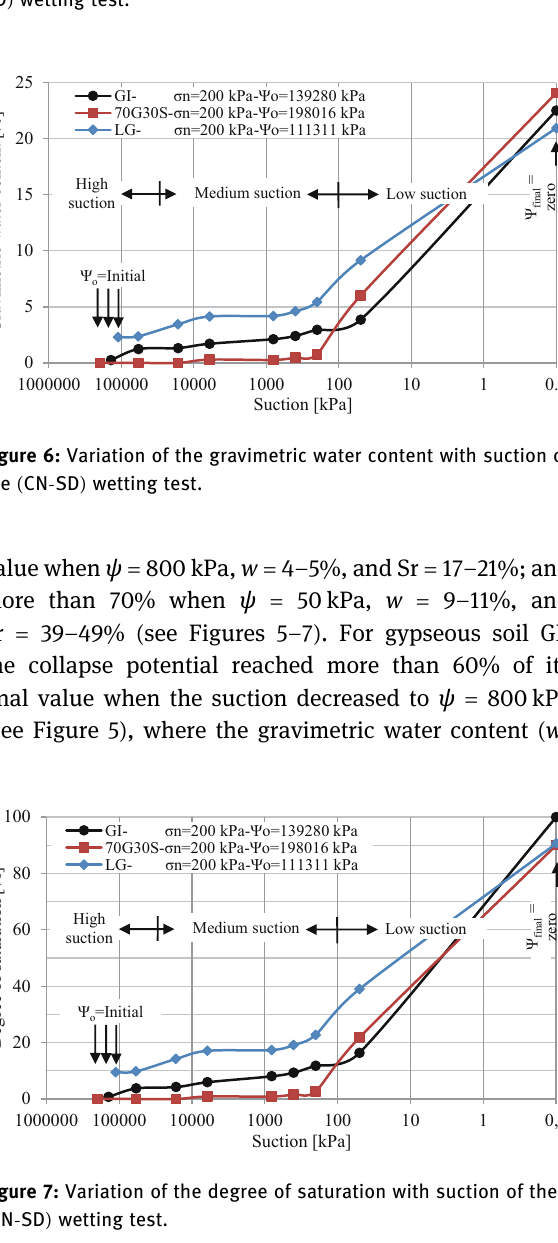
Figure 5: Variation of the collapse potential with suction of the ( CN - SD ) wetting test.